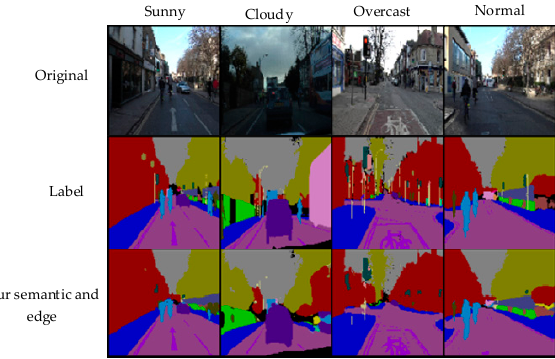
Figure 11. Segmentation results on the CamVid dataset.